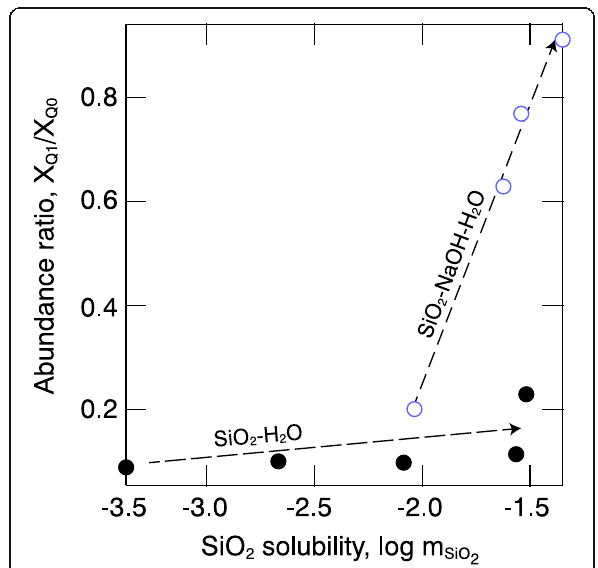
Fig. 7 Silicate species abundance ratio, X Q1 / X Q0 ( X = mol fraction) as a function of SiO 2 solubility